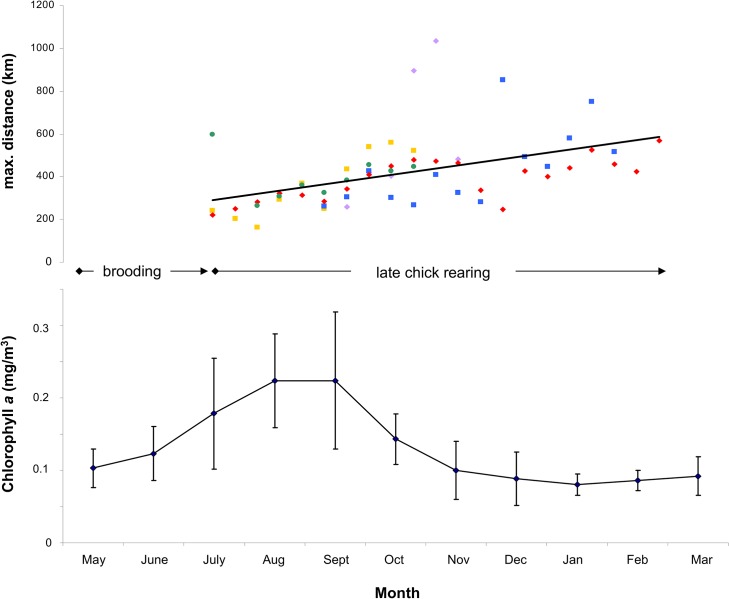
Maximum foraging distances during the late chick rearing period and chlorophyll a concentrations around CI.Maximum foraging distance of female Christmas Island Frigatebirds during the late chick rearing period (each individual in a different colour, regression line in black) and chlorophyll a concentration around CI (monthly means for study period 2005–2010, with SD).